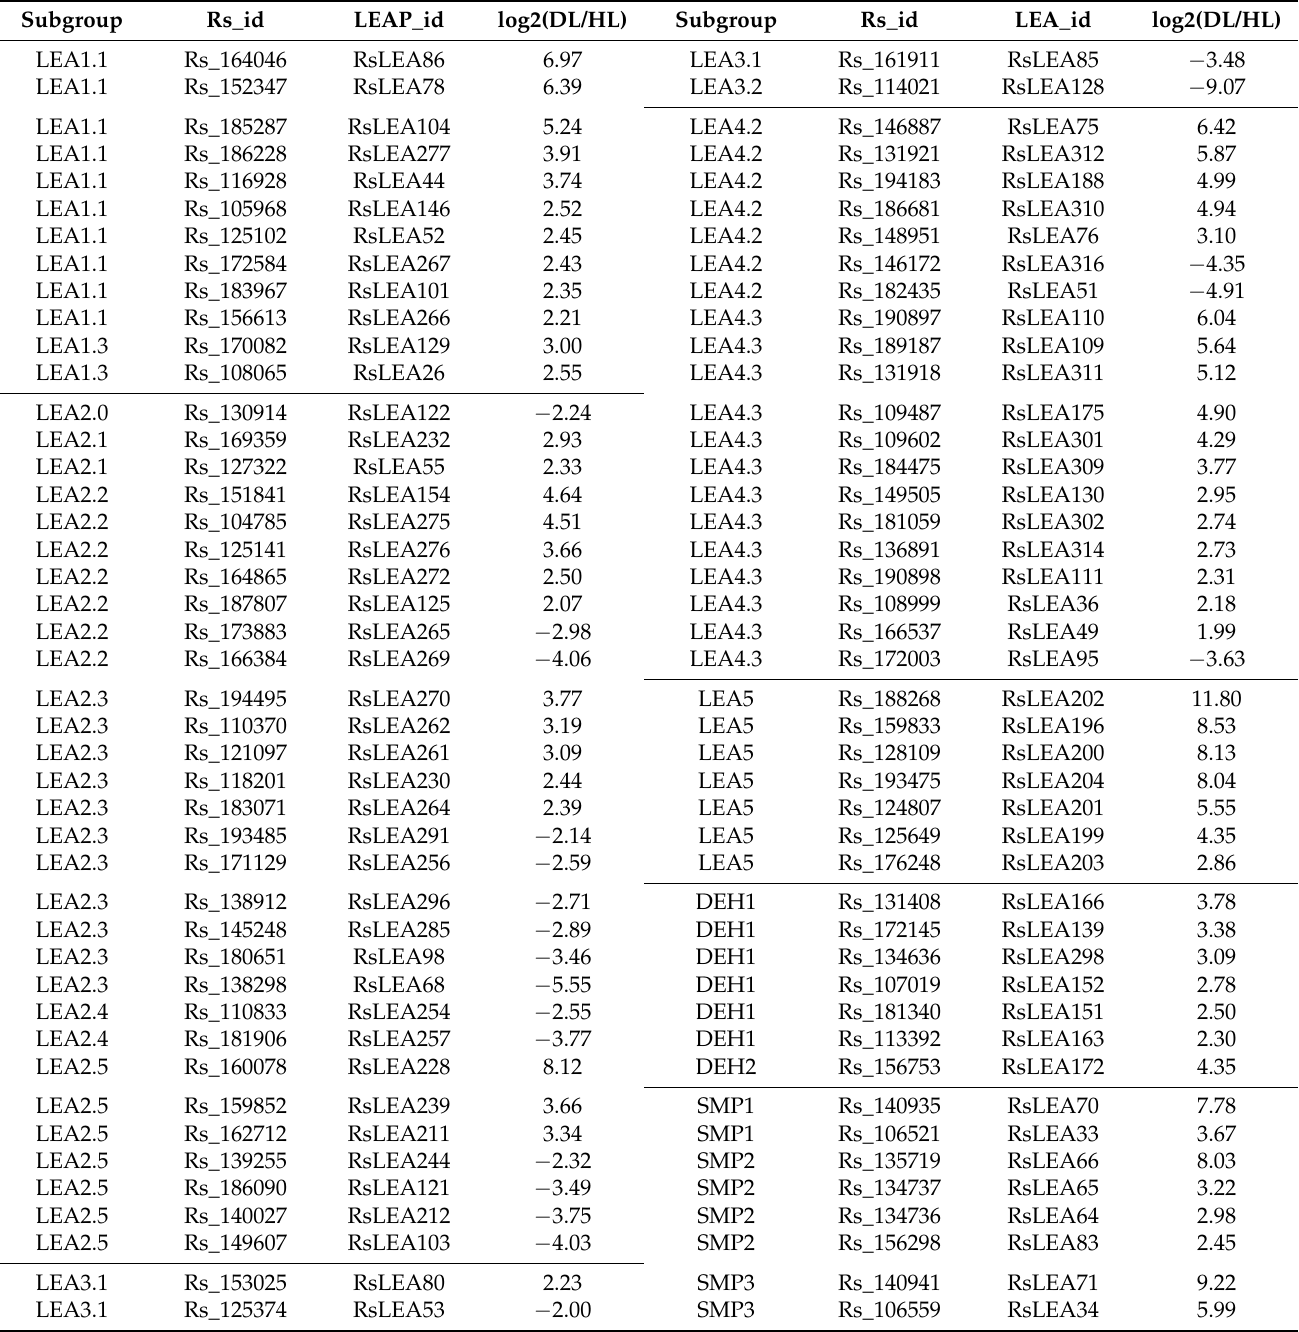
Table 4. Differentially expressed genes encoding annotated LEAPs in R. serbica upon